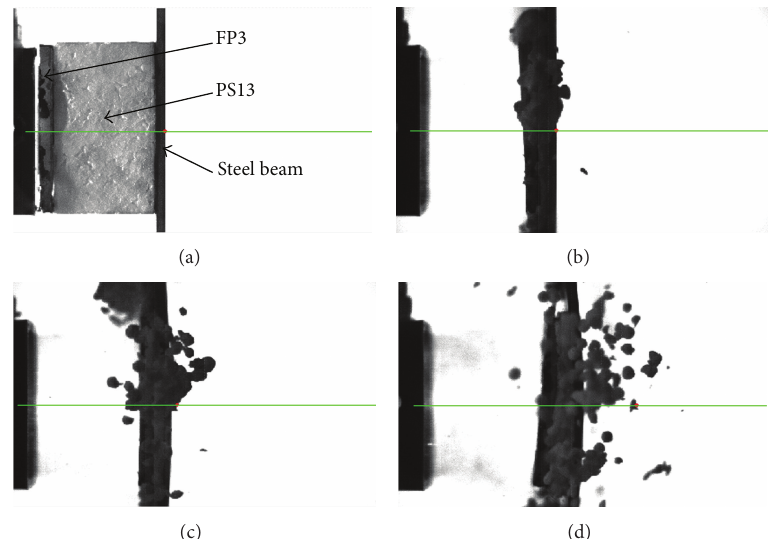
Figure 13: The PS13-050-FP3 configuration before and after the blast load: (a) before the blast load, (b) fully compacted expanded polystyrene, (c) material ejection and front plate impact with the structure, and (d) material ejection and front plate recoil.